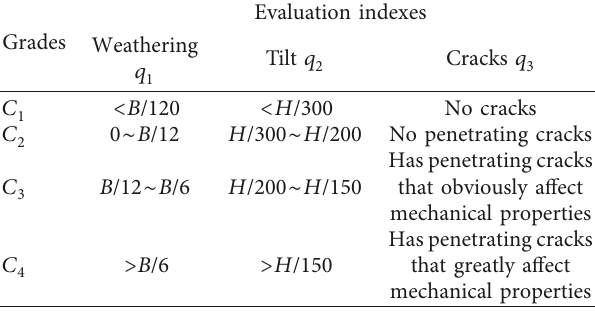
Table 9: Classification standards and evaluation index of